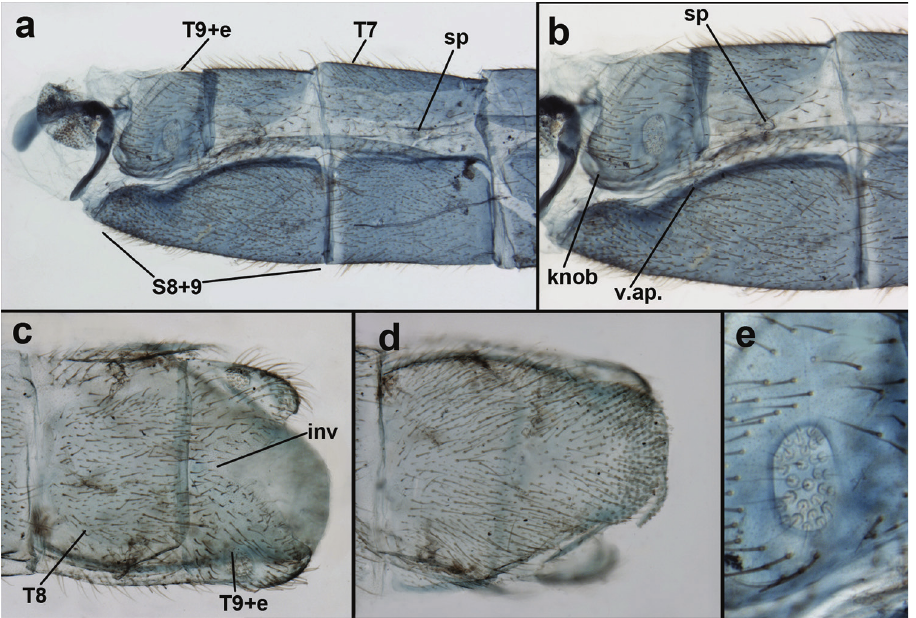
Figure 79. Ungla quchapampa Tauber, sp. n. Male abdomen, ( a ) segments A7-terminus, lateral ( b ) seg- ments A8-terminus, lateral ( c ) tergite 8, tergite 9+ectoproct, dorsal ( d ) sternite 8+9, ventral, with heavy setae ( e ) callus cerci. inv invaginated dorsal cleft in T9+ectoproct sp spiracle S8+9 fused eighth and ninth sternites T7, T8 seventh and eighth tergites T9+e ninth tergite + ectoproct v.ap. apodeme on dorsal margin of S8+9 (Bolivia, Cochabamba, holotype, MCZ). pedicel, flagellum dark brown to black basally, becoming lighter distally, with cream- colored intersegmental membrane; maxillary palp with basal two segments pale, three distal segments black, articulations pale; labial palp with basal segment pale, distal two segments marked with